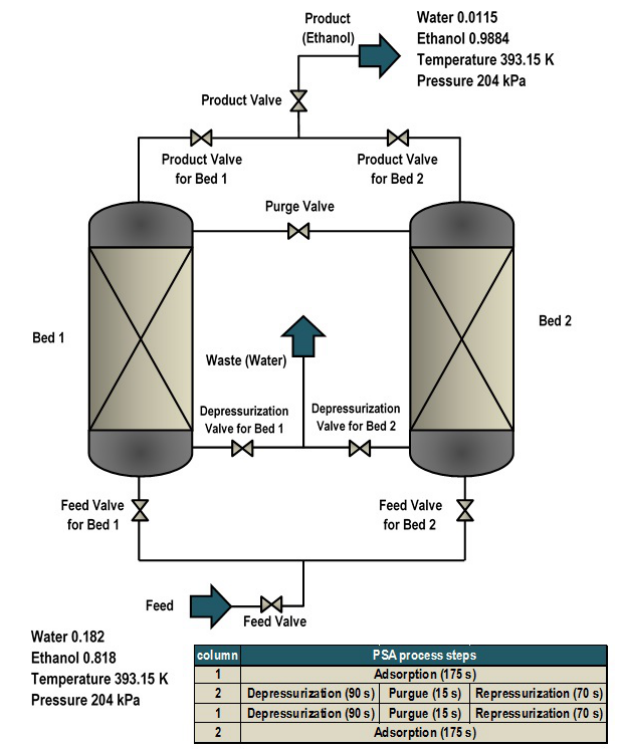
Figure 8. Pressure swing adsorption